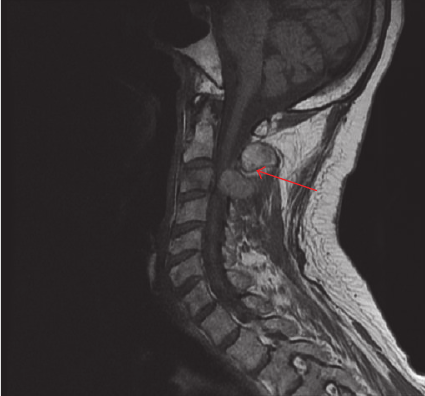
Figure 2: MRI of cervical spine: destructive enhancing mass at level of C2-C3 with evidence of spinal cord compression.